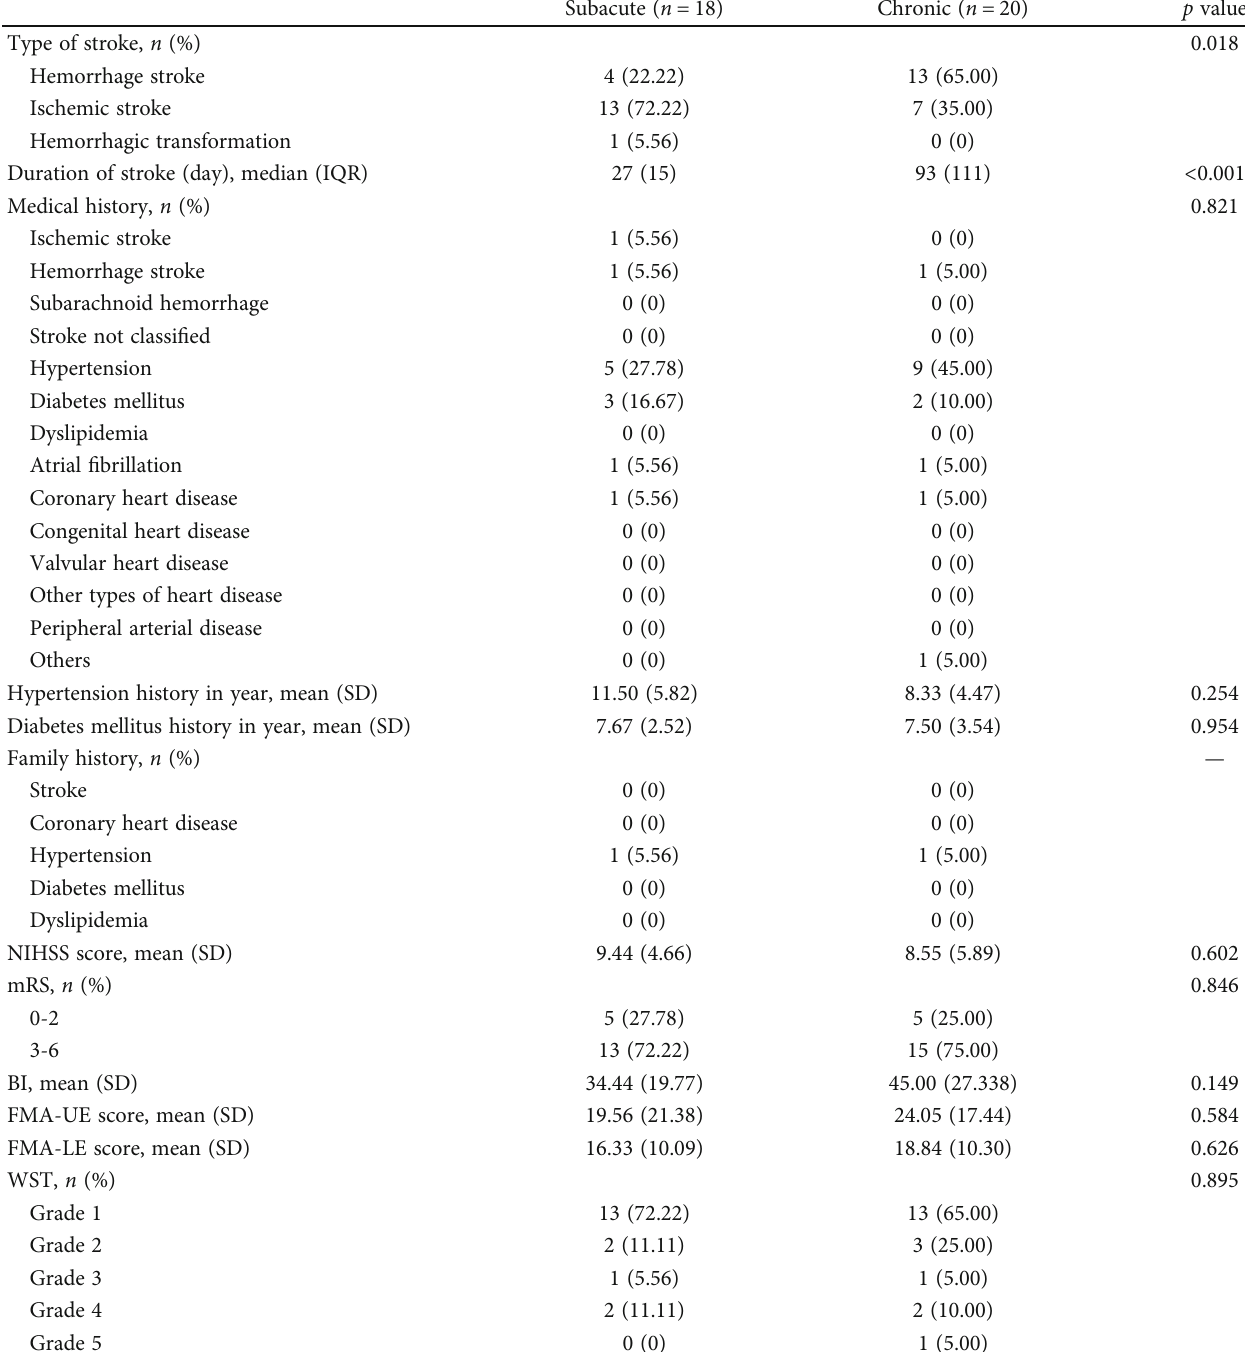
Table 2: Summary of clinical characteristics in patients with subacute or chronic